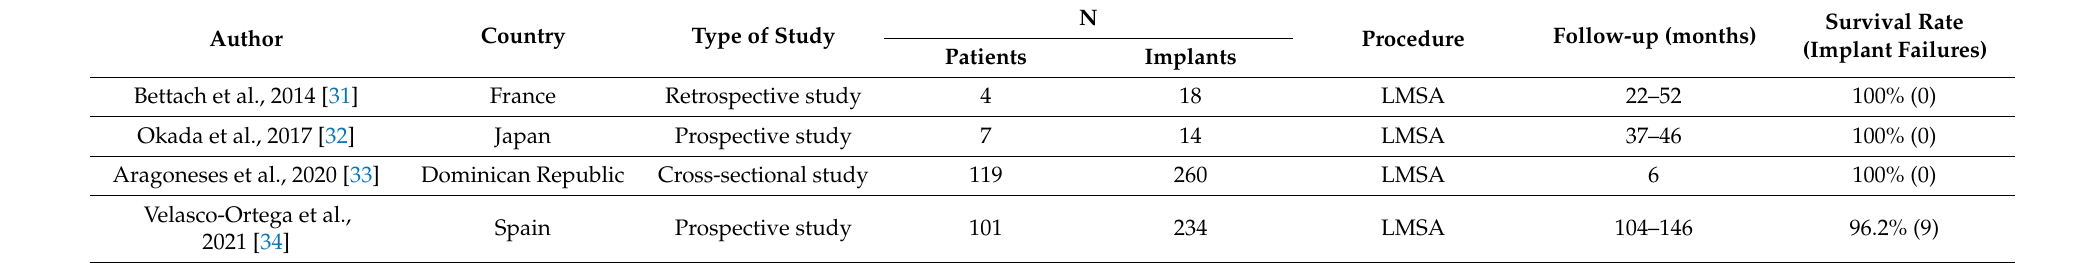
Table 2. Summary of the included non-comparative studies. Abbreviations: LMSA, lateral maxillary sinus